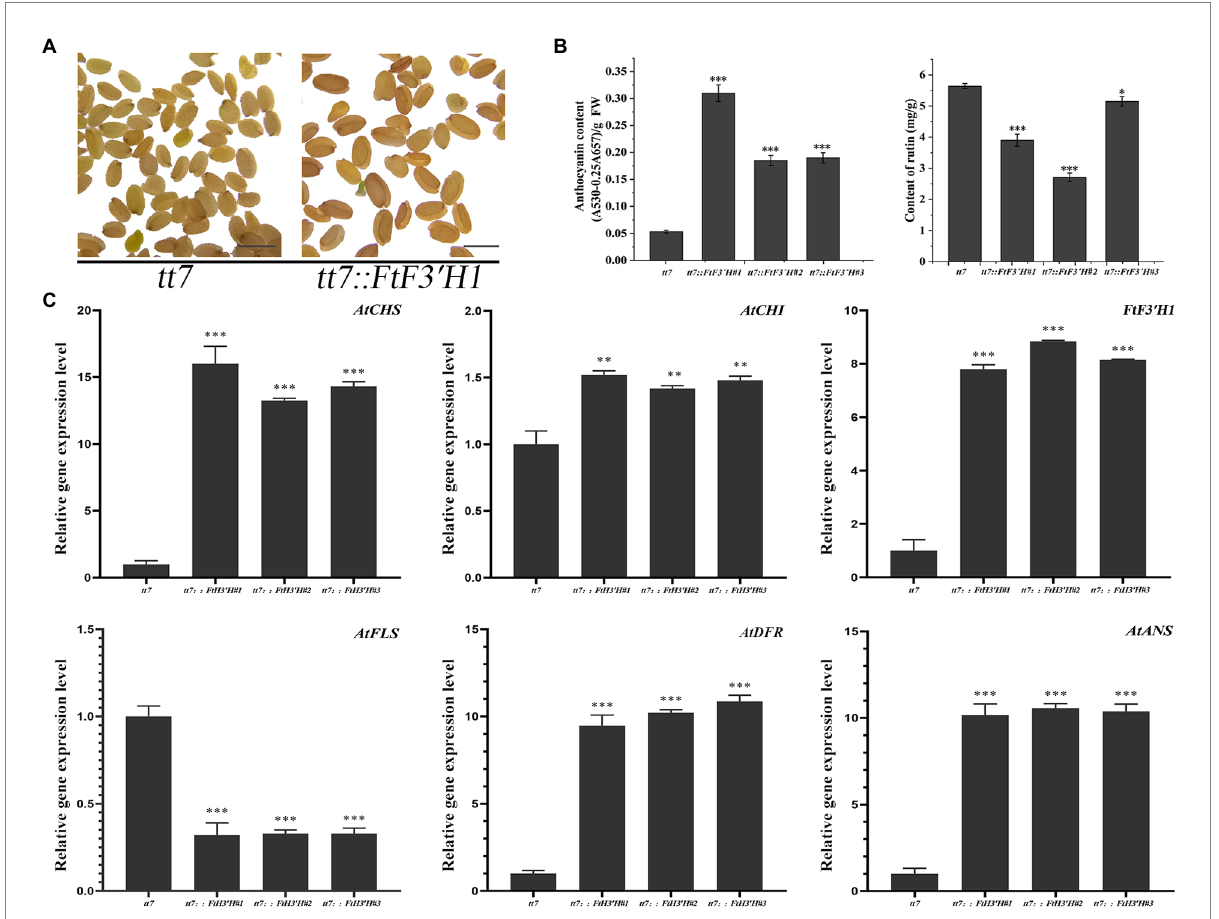
FIGURE 5 The original phenotype was restored after complementation of FtH3 ′ H1 in tt7 . (A) The seed coat color of A. thaliana tt7 with or without FtH3 ′ H1 (scale bar = 0.05 cm). (B) Determination of anthocyanin and rutin content in the corresponding Arabidopsis as indicated. Each value represents the mean of three replicates, and error bars indicate ± SD. * p < 0.05, ** p < 0.01 and *** p < 0.001. (C) Transcription level of genes related to the anthocyanin biosynthesis in transgenic materials. Atactin2 was used as the reference gene. Results represent mean values ± SD from